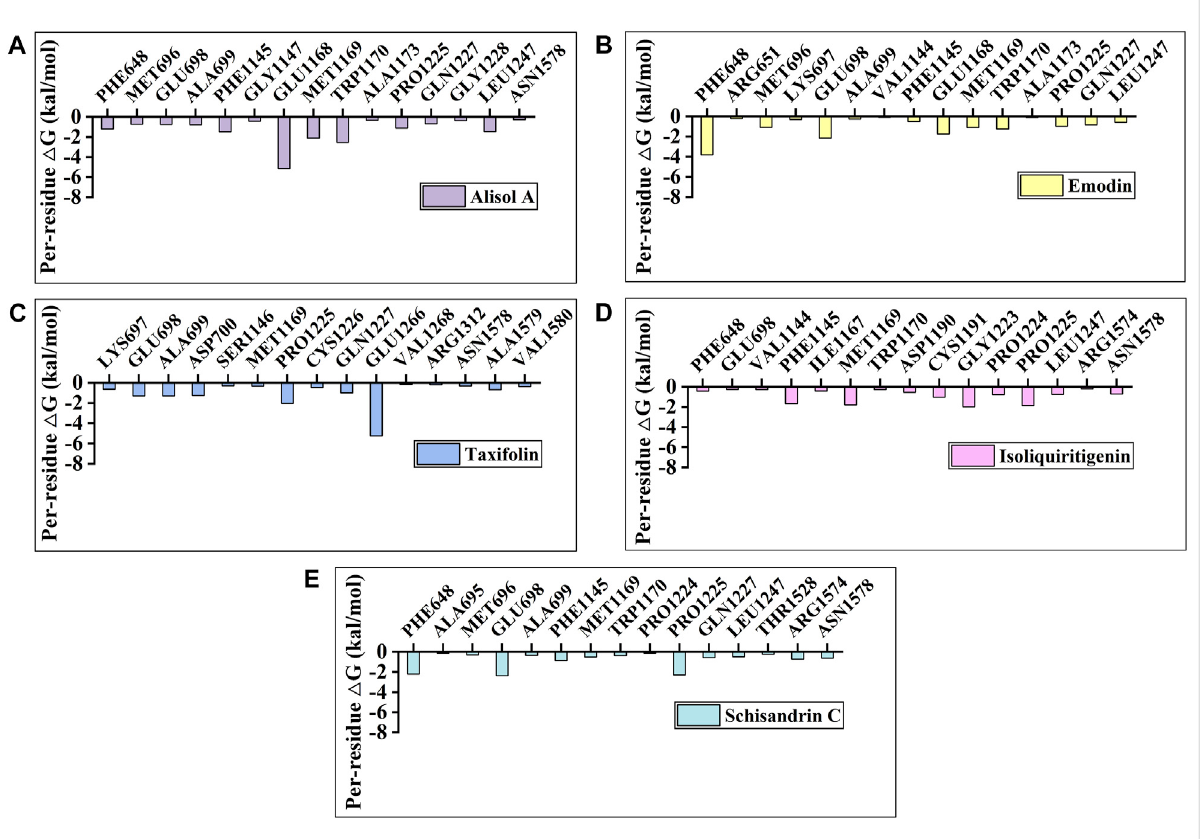
FIGURE 8 Per-residue binding free energy decomposition of (A) Alisol A; (B) Emodin; (C) Taxifolin; (D) Isoliquiritigenin; and (E) Schisandrin C binding to